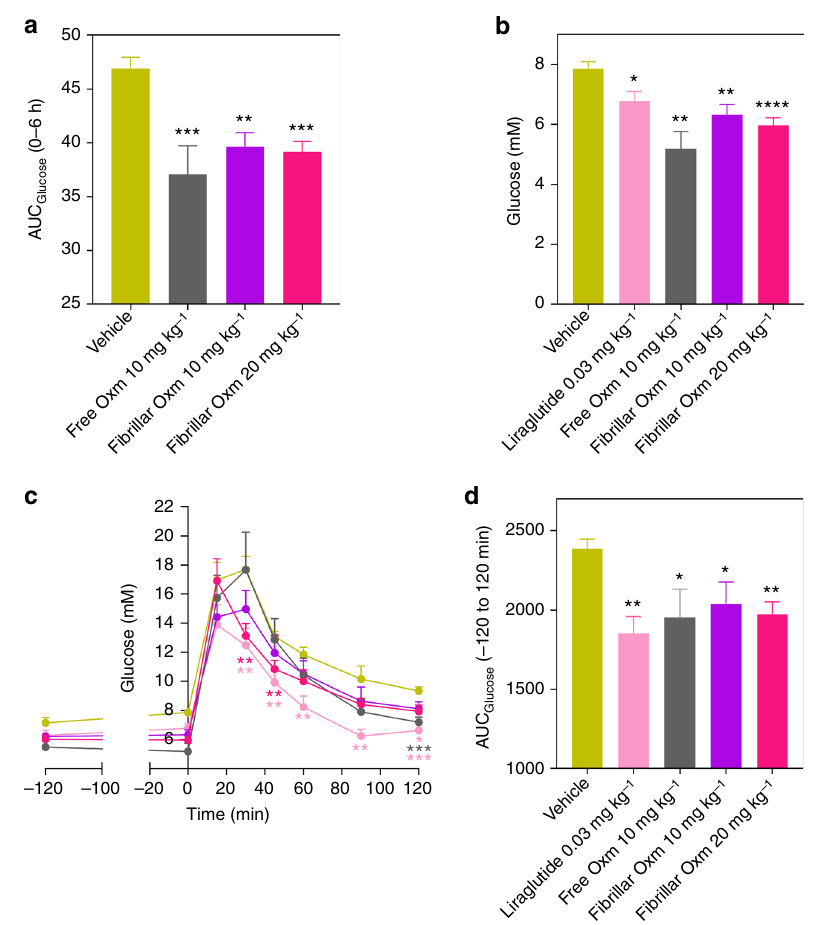
Fig. 6 Effect of fi brillar Oxm on blood glucose lowering. Glucose lowering demonstrated after 6 h of administration with either vehicle or free and fi brillar Oxm by either AUC a , or blood glucose concentration at 6 h b . A glucose tolerance test (GTT) was conducted at 6 h post-dose c and ef fi cacy was also expressed by AUC d . Liraglutide was used as positive control and administrated 2 h prior to GTT. Data are mean ± s.e.m. ( n = 7 – 8 animals per group). * P < 0.05, ** P < 0.01, *** P < 0.001, **** P < 0.0001, vs. vehicle, two-sided, unpaired t -test fi brillar state of Oxm is not acutely cytotoxic at the concentrations through bioreduction of a resazurin-based dye (Fig. 5c). None of the forms of Oxm were cytotoxic at concentrations up to 1000- tested and can be used as a reservoir in which active and nontoxic fold above the EC 50 value in the CHO-hGLP-1R cell line. Two peptides can be stored and released upon dissociation of the positive control cytotoxic agents, Ro-318220 and staurosporine, nano fi brils under physiological conditions. Our result is in both protein kinase C inhibitors, showed the expected curves of agreement with studies describing mature fi brils as harmless concentration vs. loss of cell viability. These studies show that the reservoirs of polypeptides with the toxic species being the non- NATURE COMMUNICATIONS | 8: 1026 | DOI: 10.1038/s41467-017-01114-1 |